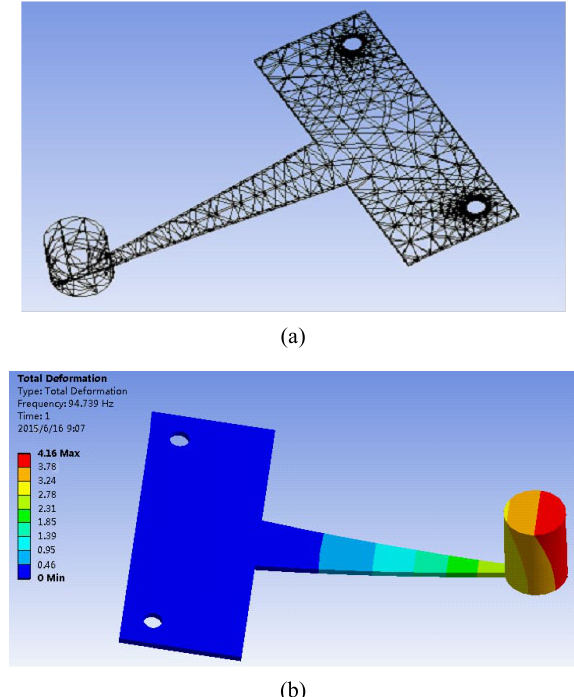
Fig. 3 Meshing the vibration sensor and finite element analysis: (a) mesh generation and (b) strain distribution of the first-order resonance.